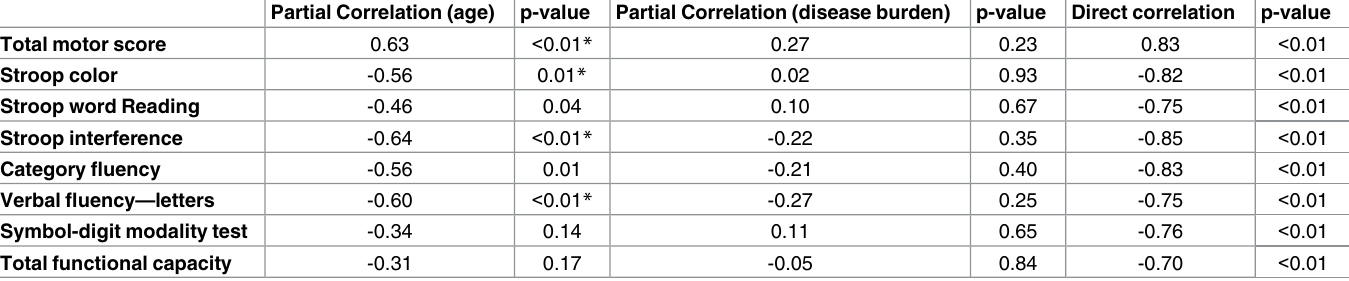
Table 2. Spearman correlations between NFL and clinical test scores adjusted for age and adjusted for disease burden compared with the direct correlations.